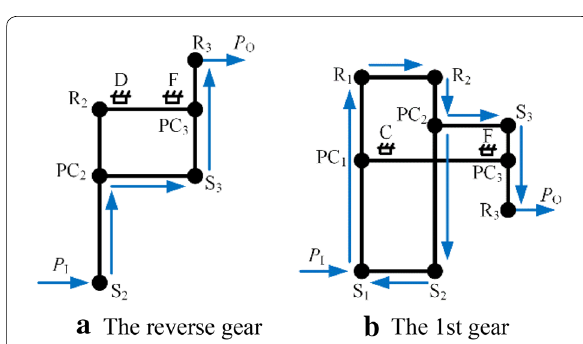
Figure 17 Power flow diagrams under the reverse gear and the 1st gear